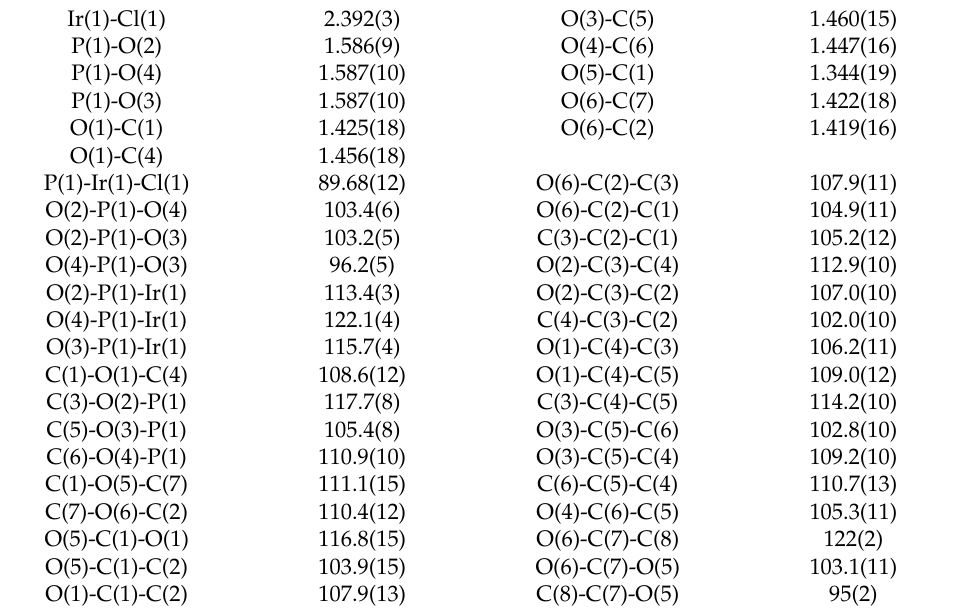
Figure 3. Molecular structure of 8 . Table 1. Selected bond lengths (Å) and bond angles ( ◦ ) for 8